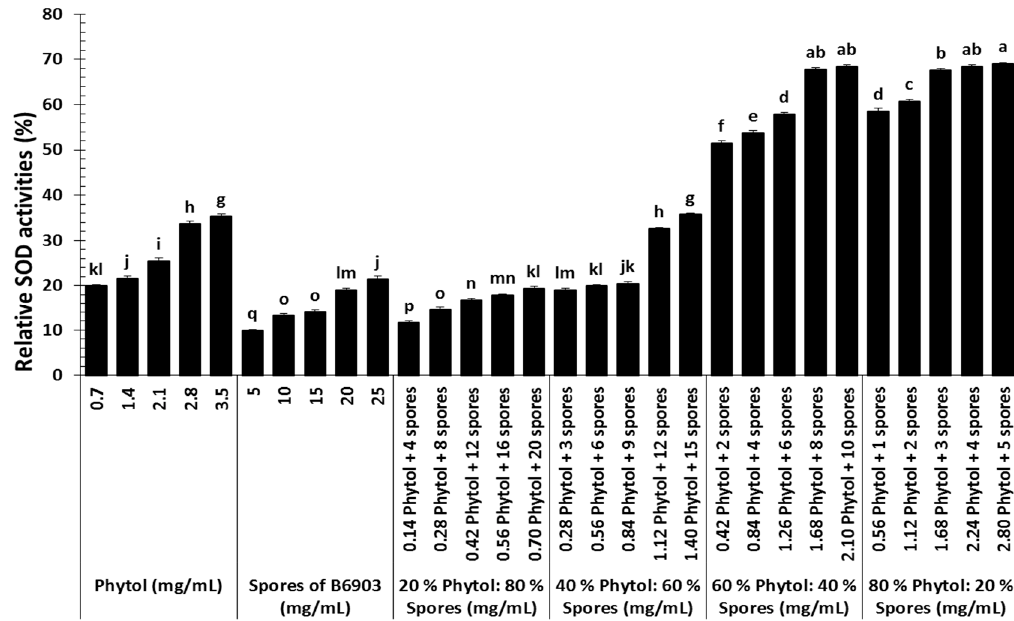
Figure 4. Superoxide dismutase (SOD) activities (%) of Oligonychus afrasiaticus (McGregor) fed on date palm leaf disks treated with different combinations of phytol and spores of Beauveria bassiana B6903 relative to control. Bars (means ± SE) followed by different letter(s) are significantly different (Fisher’s LSD test, α = 0.05).